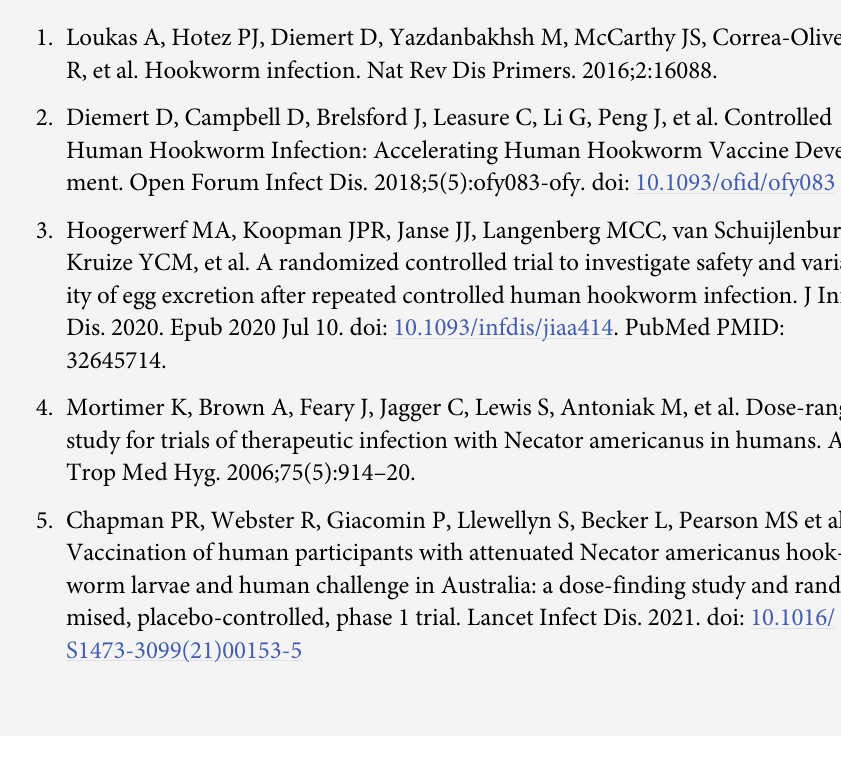
S1 Table. Studies included in this narrative